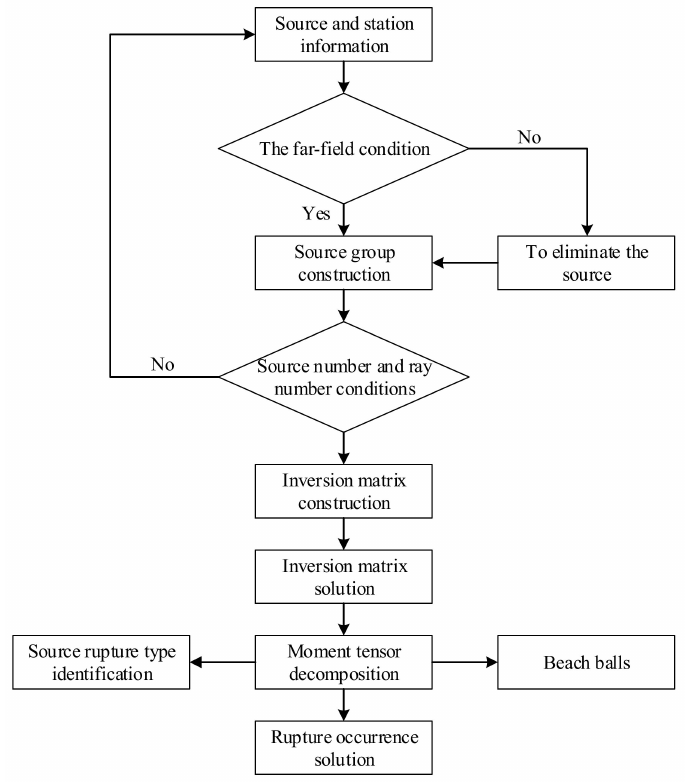
Figure 6. Flowchart for implementing the method to